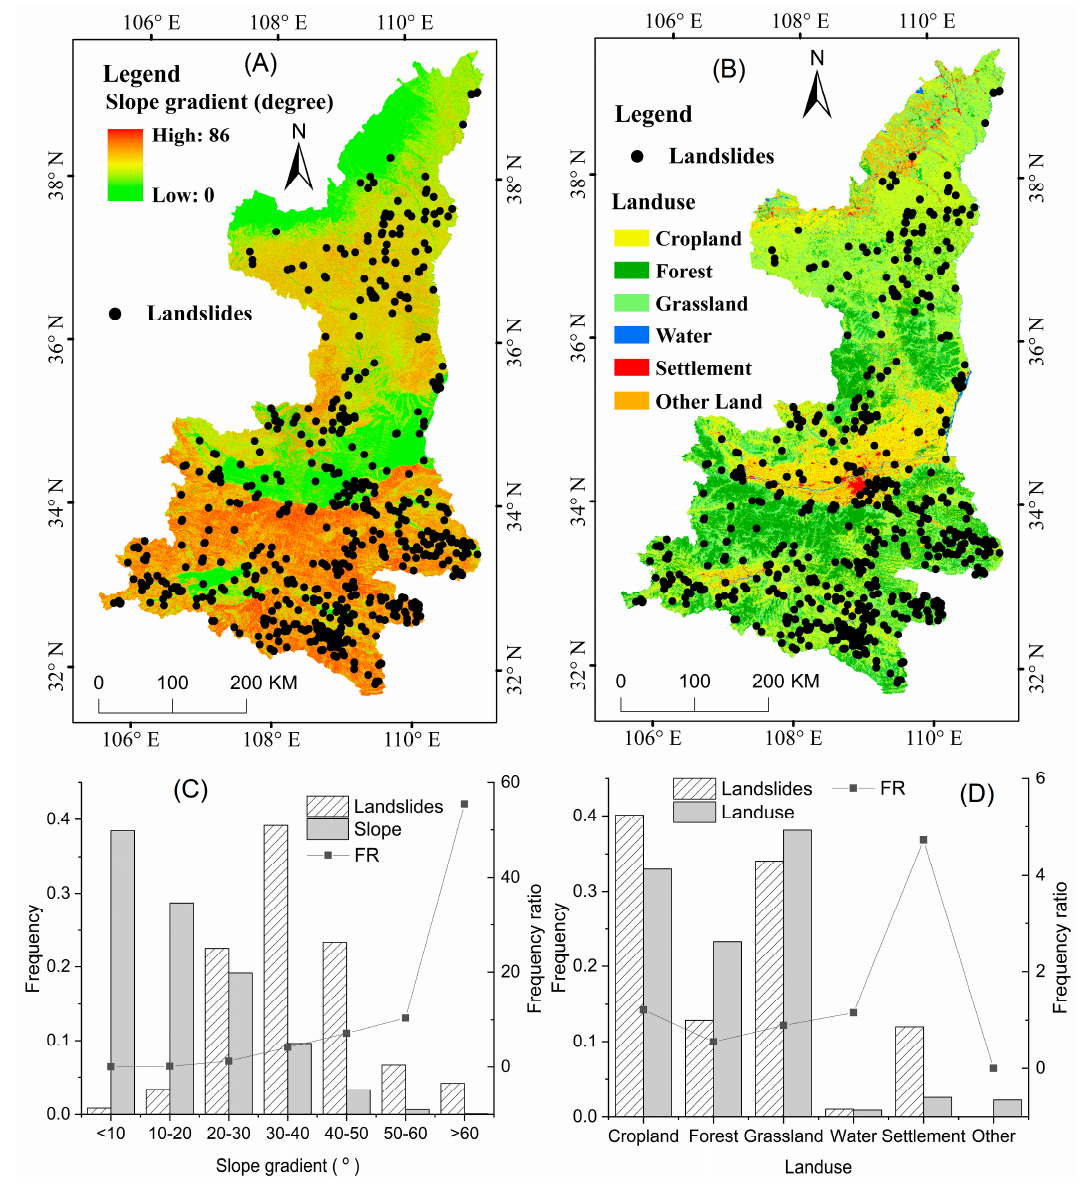
Figure 13. Relationships between landslides and influencing factors: Left ( A , C ) slope gradient and Right ( B , D ) land use.